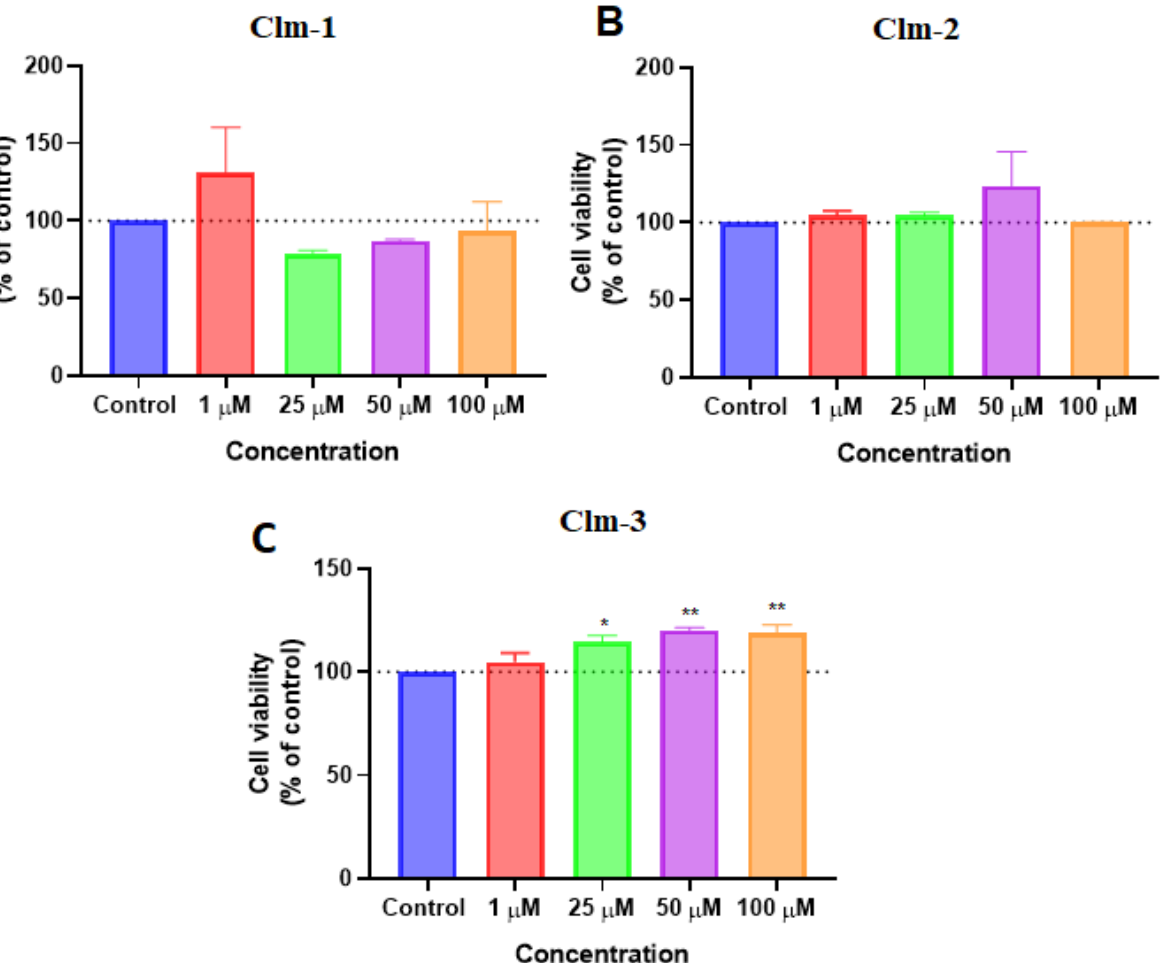
Figure 3. Cytotoxicity evaluation of compounds ( A ) Clm-1 , ( B ) Clm-2 , and ( C ) Clm-3 in MCF-7 cells. MCF-7 were treated with vehicle (methanol) and increasing concentrations (0–100 µM) of each compound for 48 h and cell viability was assessed by MTT assay. Data are given as the mean ± SEM ( n = 3), * statistically significant vs. control (vehicle) at p < 0.05; ** statistically significant vs. control (vehicle) at p < 0.01.